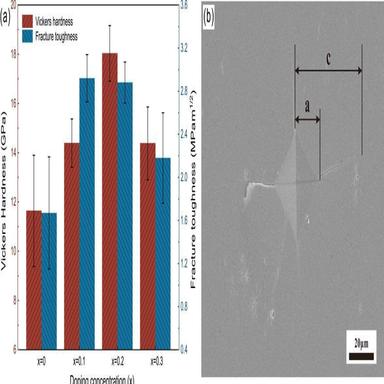
(a) Vickers hardness and fracture toughness of (Y1-xLax)3Al5O12 (x = 0, 0.1, 0.2, 0.3) samples, (b) typical Vickers indentation morphology of the (Y1 xLax)3Al5O12 samples.